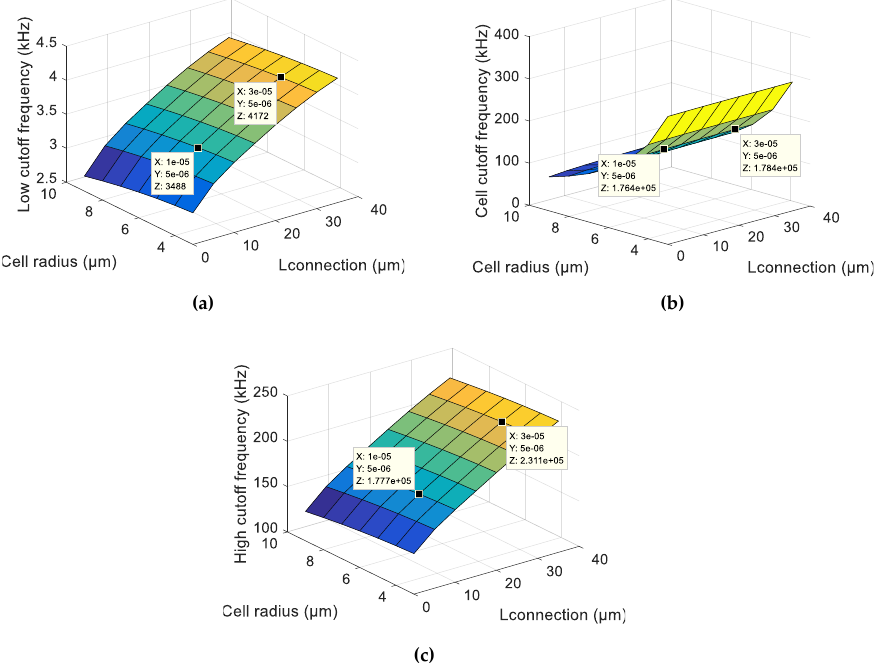
Figure 9. ( a ) Low cutoff frequency; ( b ) cell cutoff frequency; and ( c ) high cutoff frequency in the function of the connection length and cell radius from the numerical model.